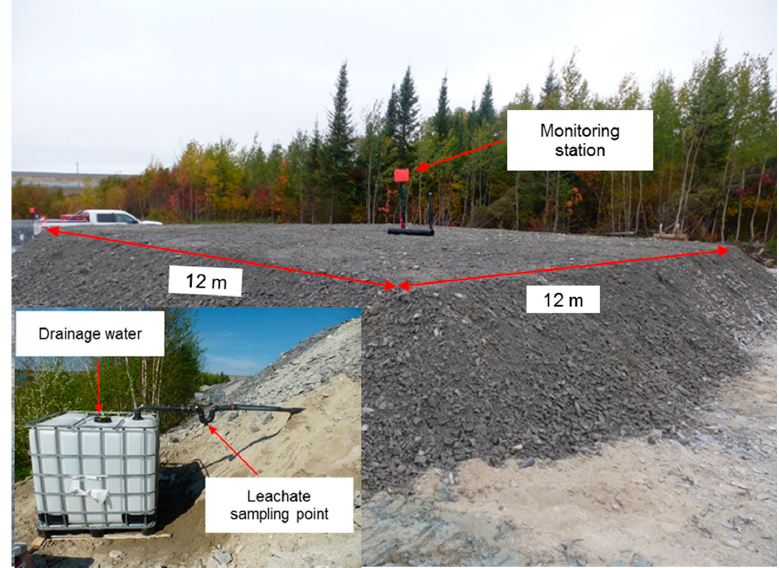
Figure 4. Picture of the CCBE field cell at the end of construction with the tote used to collect drainage water.